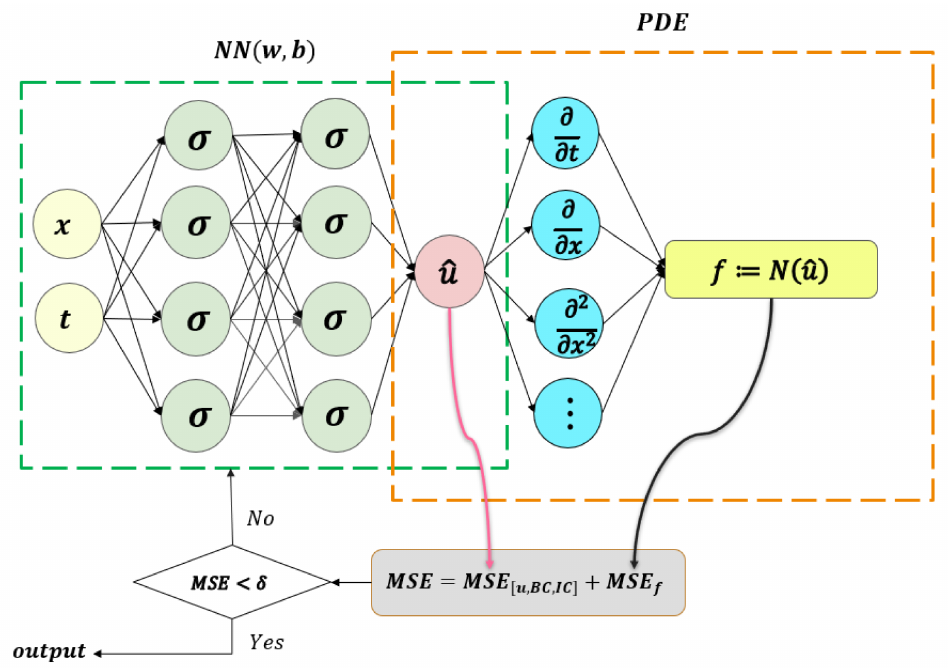
Figure 8. In a typical physics informed neural network shown schematically in the figure [67], the prior information from physics is encoded into the neural network. The PINN is employed for solving partial differential equations